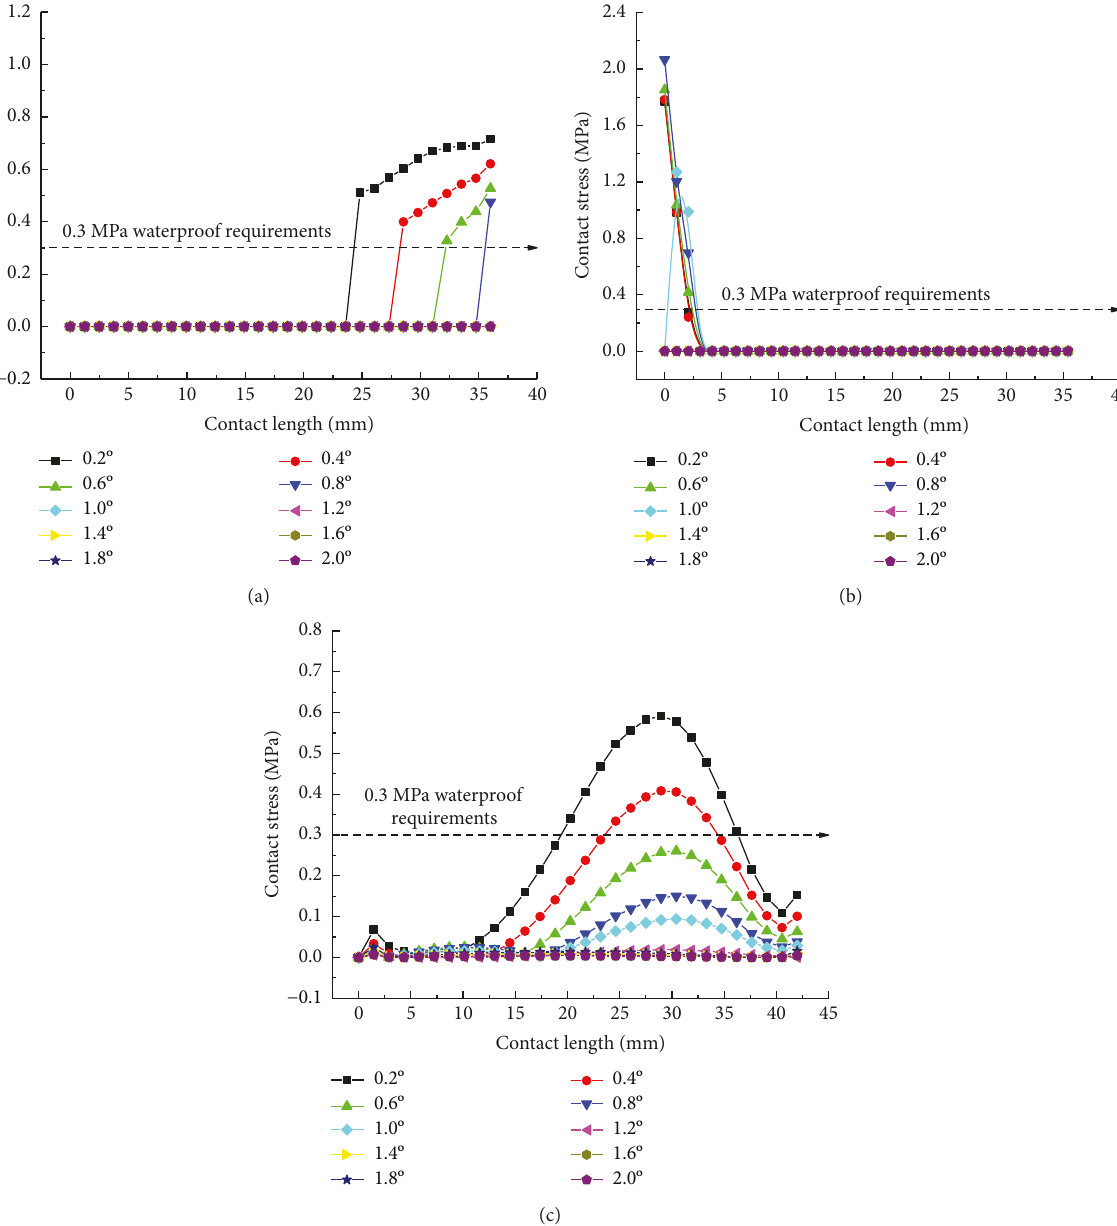
Figure 22: Contact stress curve of the first rubber ring before optimizing during anticlockwise rotation: (a) contact pressure of line 1 for the first rubber ring, (b) contact pressure of line 2 for the first rubber ring, and (c) contact pressure of line 3 for the first rubber